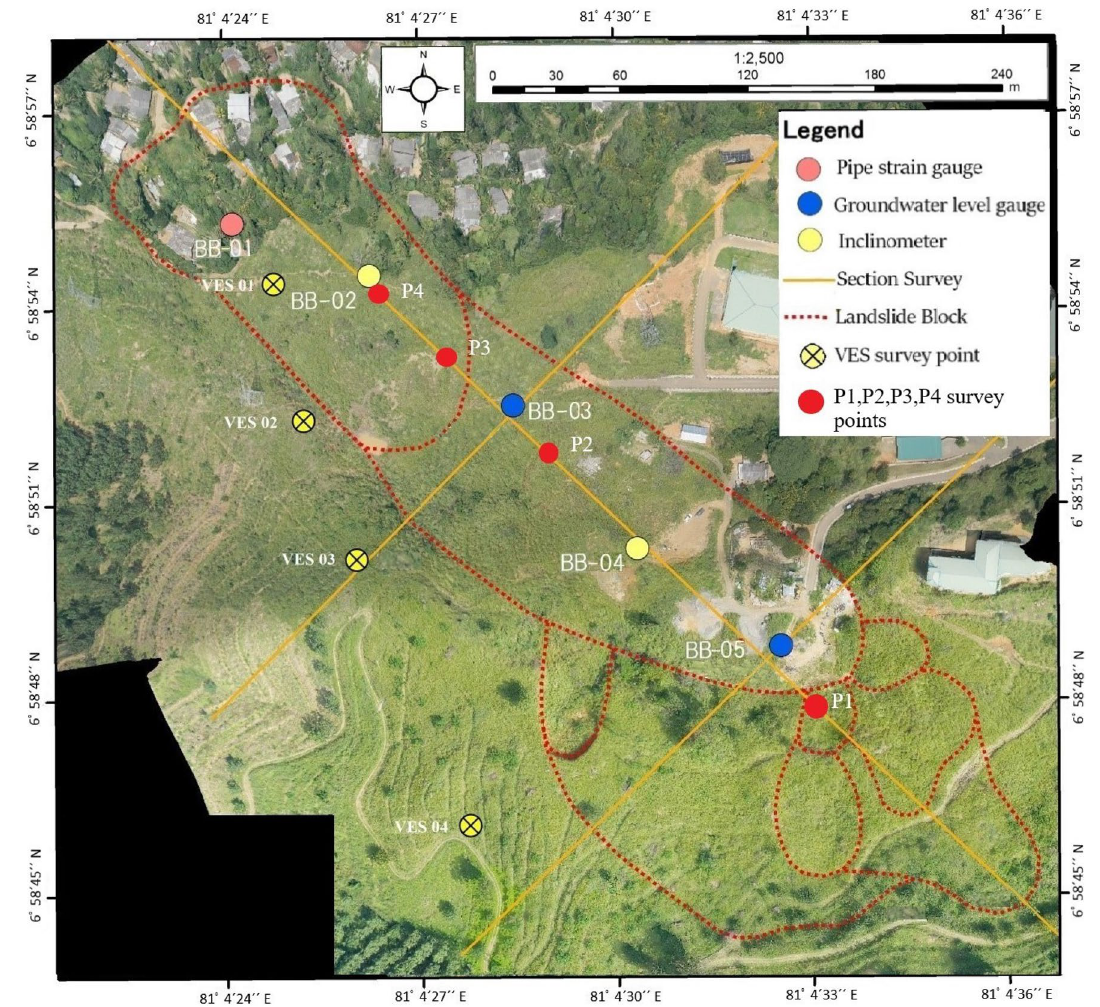
Fig. 3 Landslide area shown on a drone image (Landslide Research and Risk Management Division,